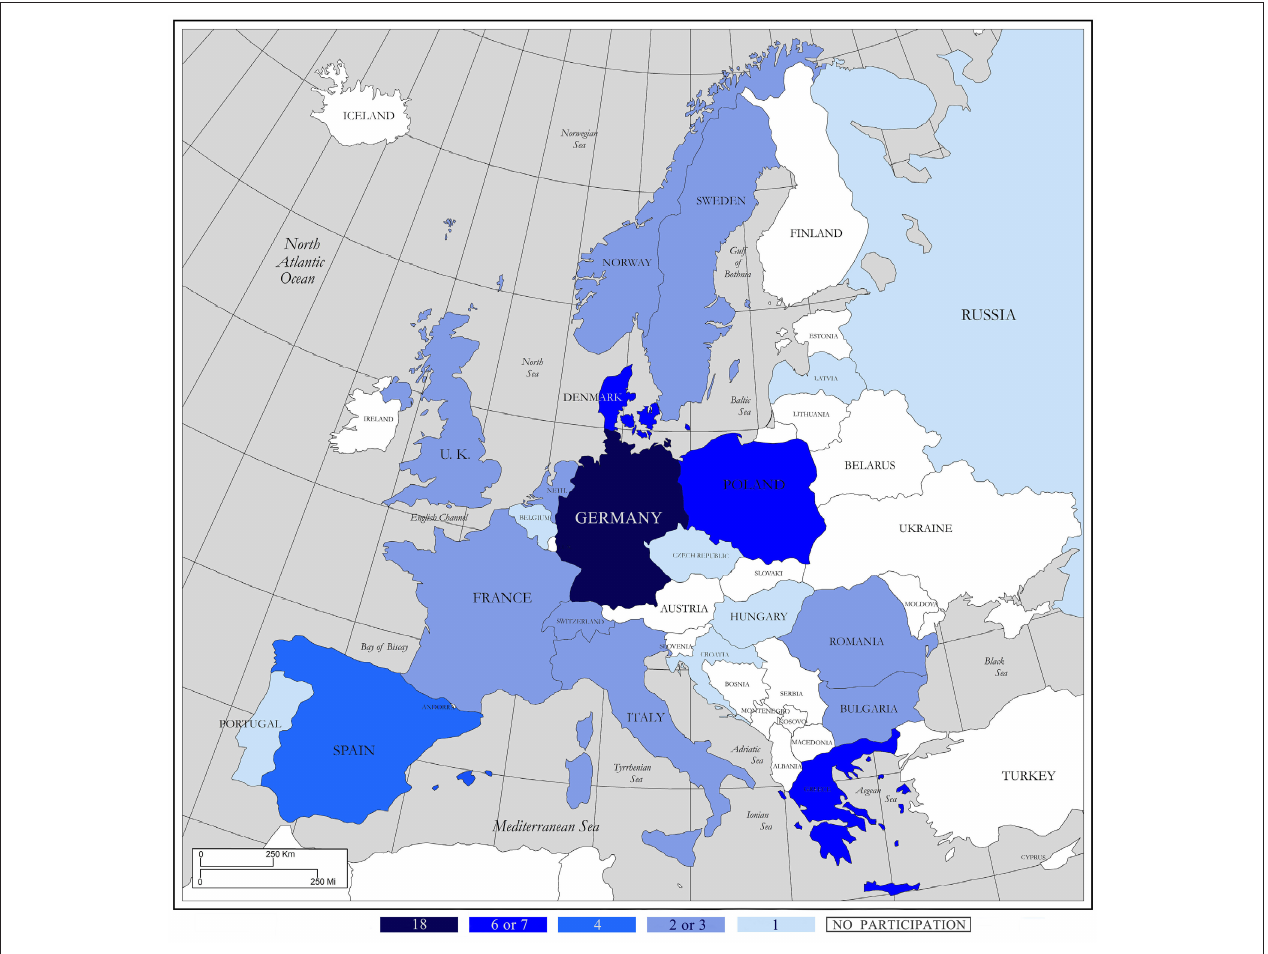
FIGURE 2 | Representation of European countries in the three